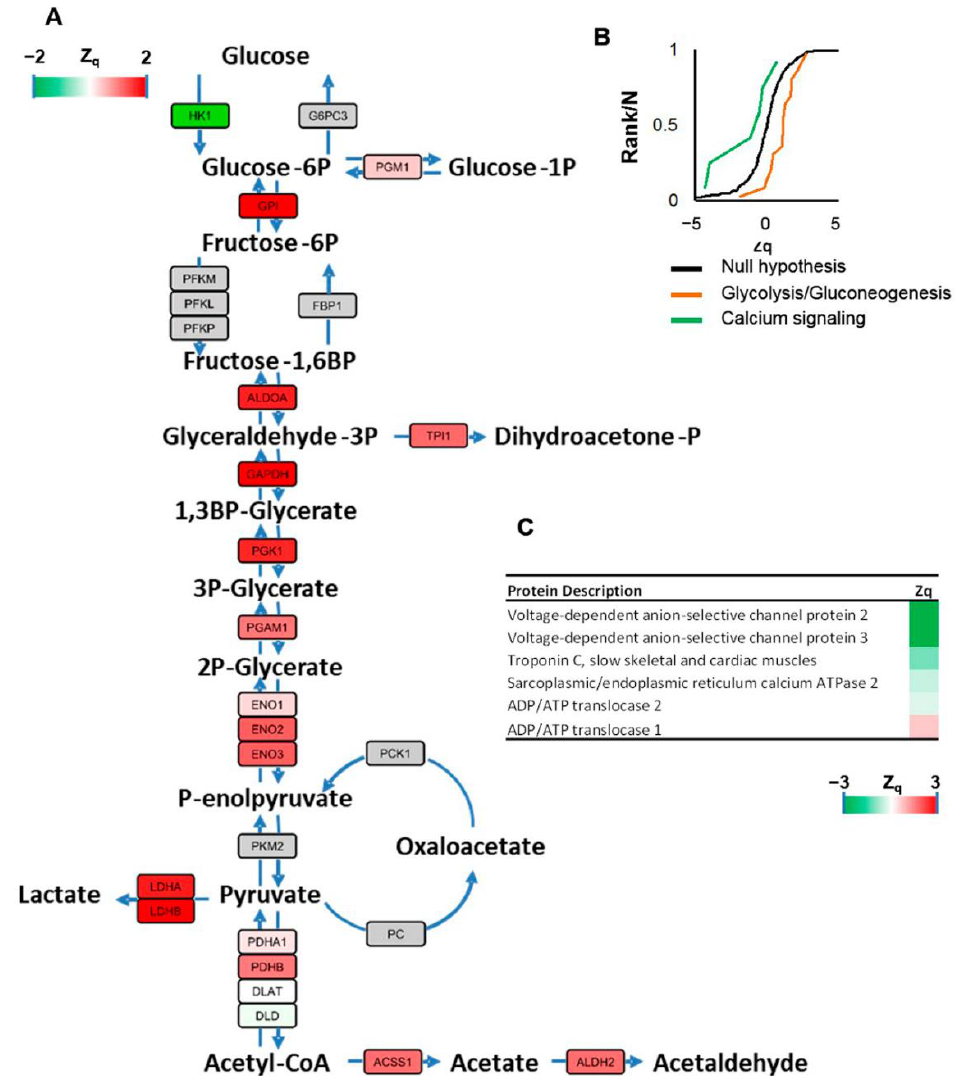
downregulated proteins. Gray symbols indicate a regulation that did not reach statistical significance. Proteins indicated in white are those available in the IPA database but not detected in the present study. The shapes of the symbols denote the molecular class of the proteins as defined in the legends. Solid lines indicate direct molecular interactions, whereas dashed lines indicate indirect molecular interactions. Network 1 ( A ) included FAHD1, PKM2, AK1, MYL2, GOT1, PLA2G4C, LDBH, PRKACA, VDAC1-3, ACTB, COX7A1, and PFKM s, whereas Network 2 ( B ) included SHOC2, ASPH, PGAMS, ACTB, COX5A, COX2, COX4I1, LAMB2, ACTN2, ENDOG, PRDX2, and POPDC2 as differentially expressed proteins.